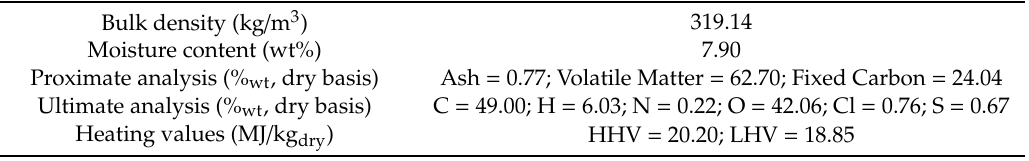
Table 2. Physical and chemical properties of hazelnut shells [39,40].